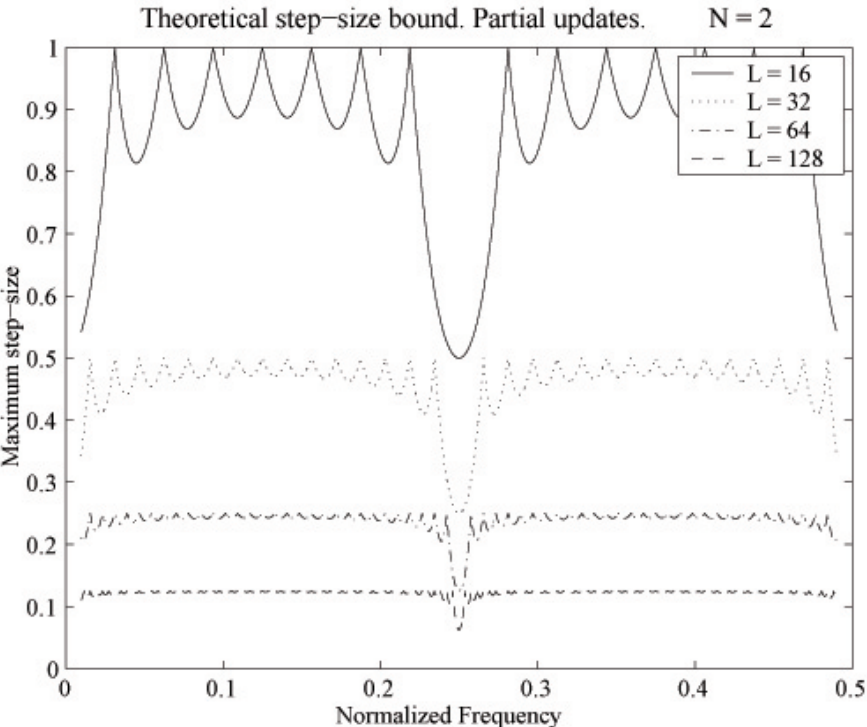
Figure A2. Step-size bound of the sequential PU LMS algorithm with decimation factor N = 2 for different filter lengths, L = 16, 32, 64, and 128. The input vector is an N -decimated single tone whose normalized frequency varies from 0 to 0.5.